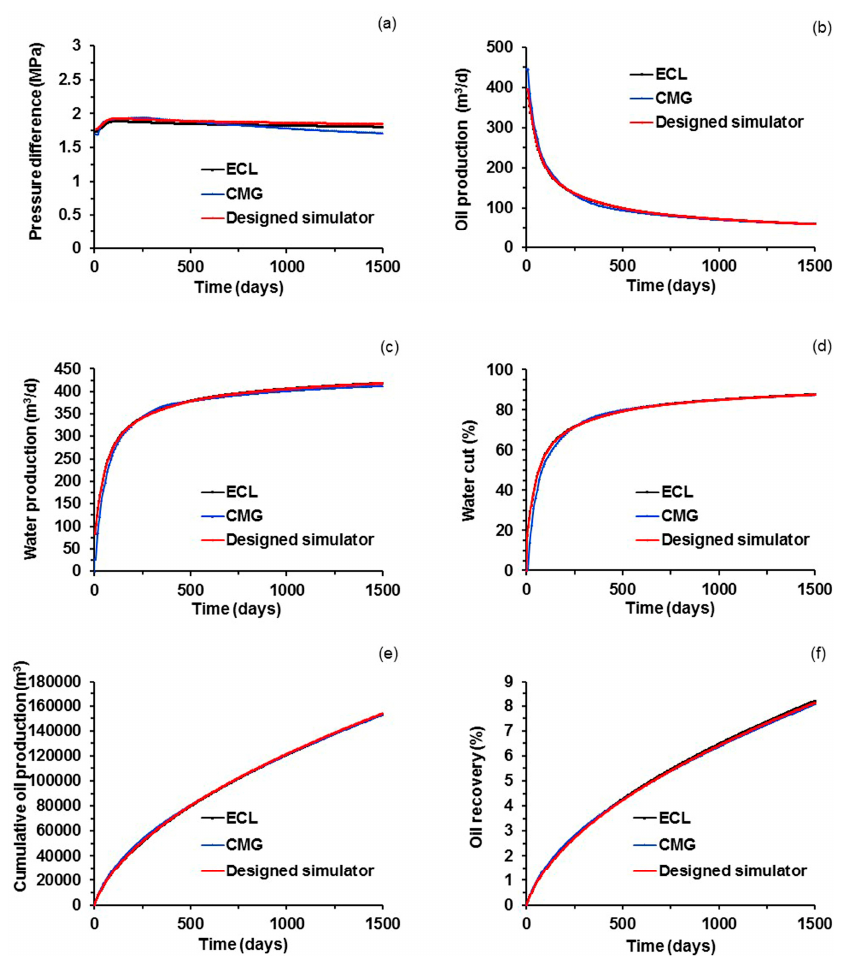
Figure 13. Comparison result of ( a ) pressure difference; ( b ) oil production; ( c ) water production; ( d ) water cut; ( e ) cumulative oil production; and ( f ) oil recovery of ECLIPSE V2013.1, CMG V2012 software and designed simulator in running the